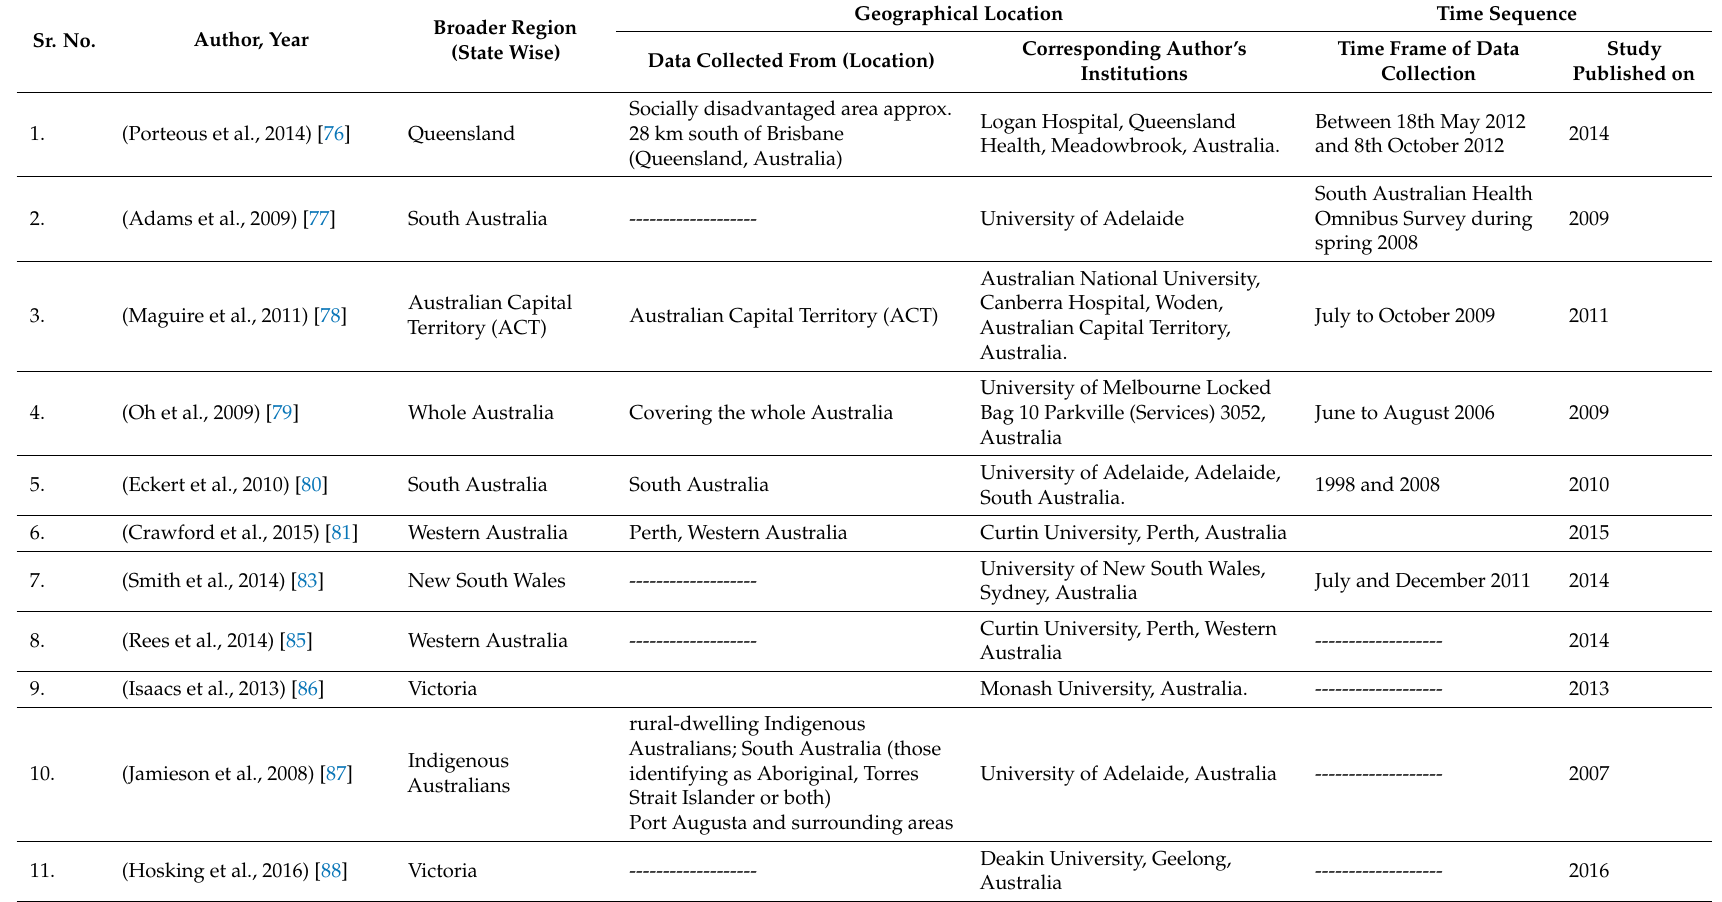
Table 4. Spatial and temporal sequence of work